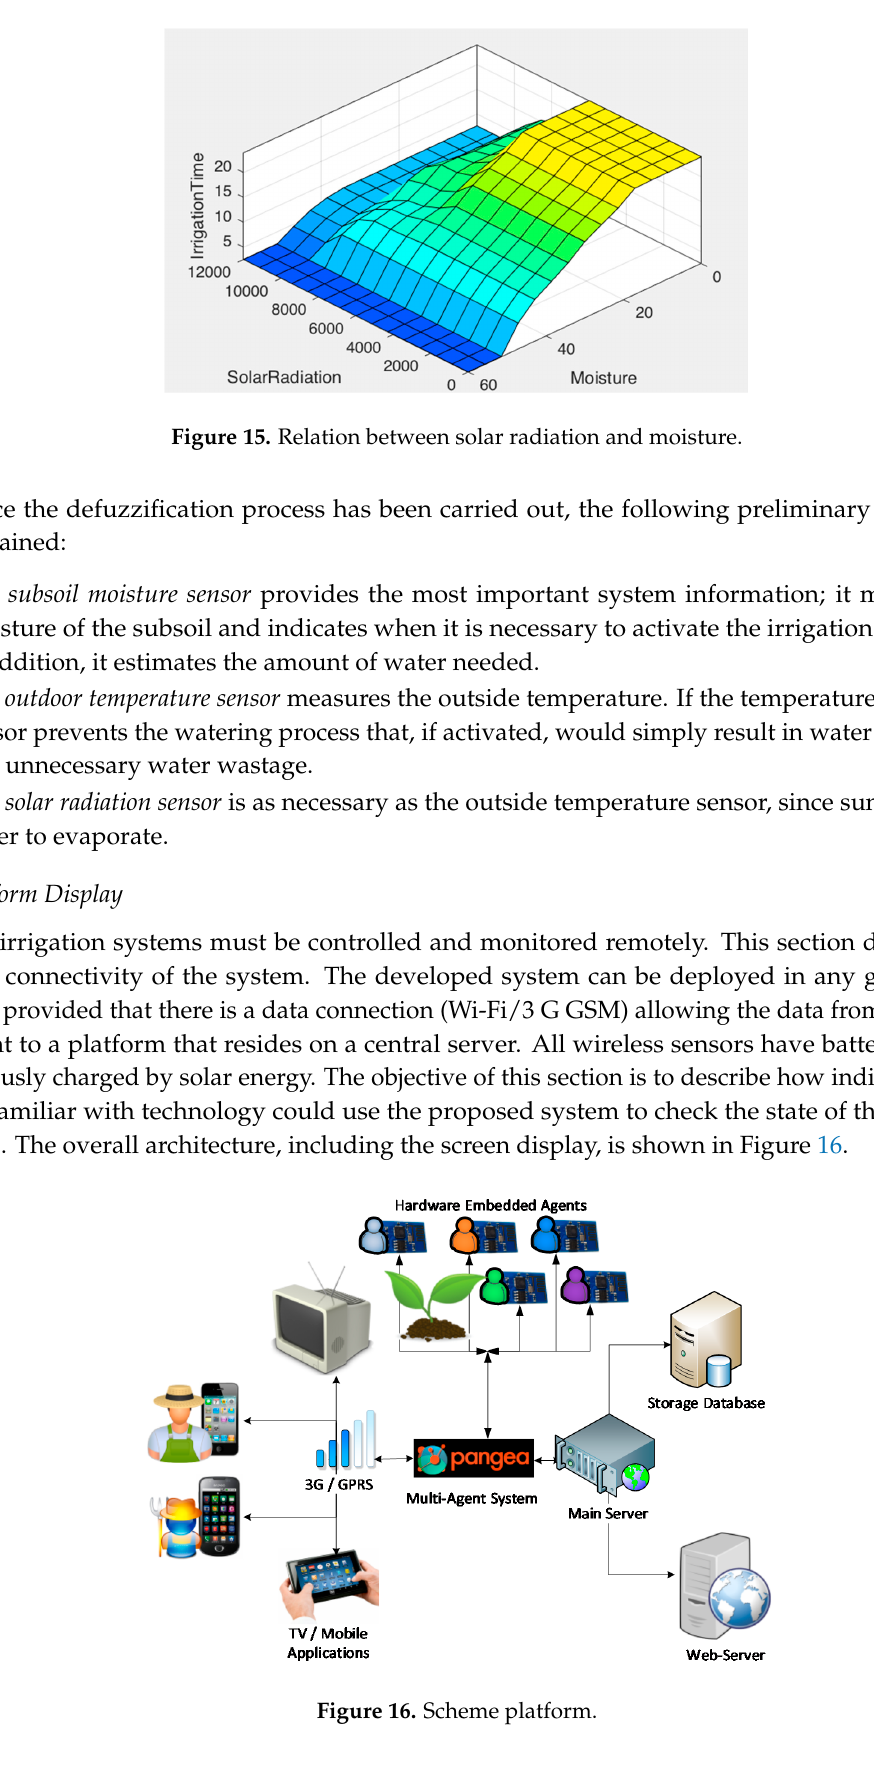
Figure 16. Scheme platform.